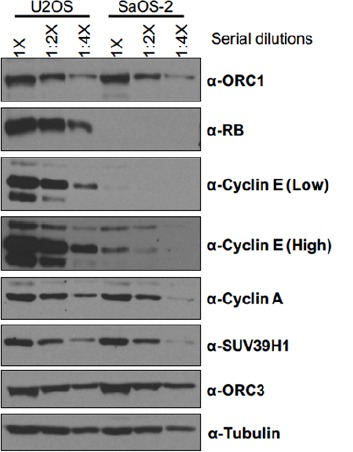
Protein levels in U2OS cells and SaOS-2 cells detected by immunoblot.